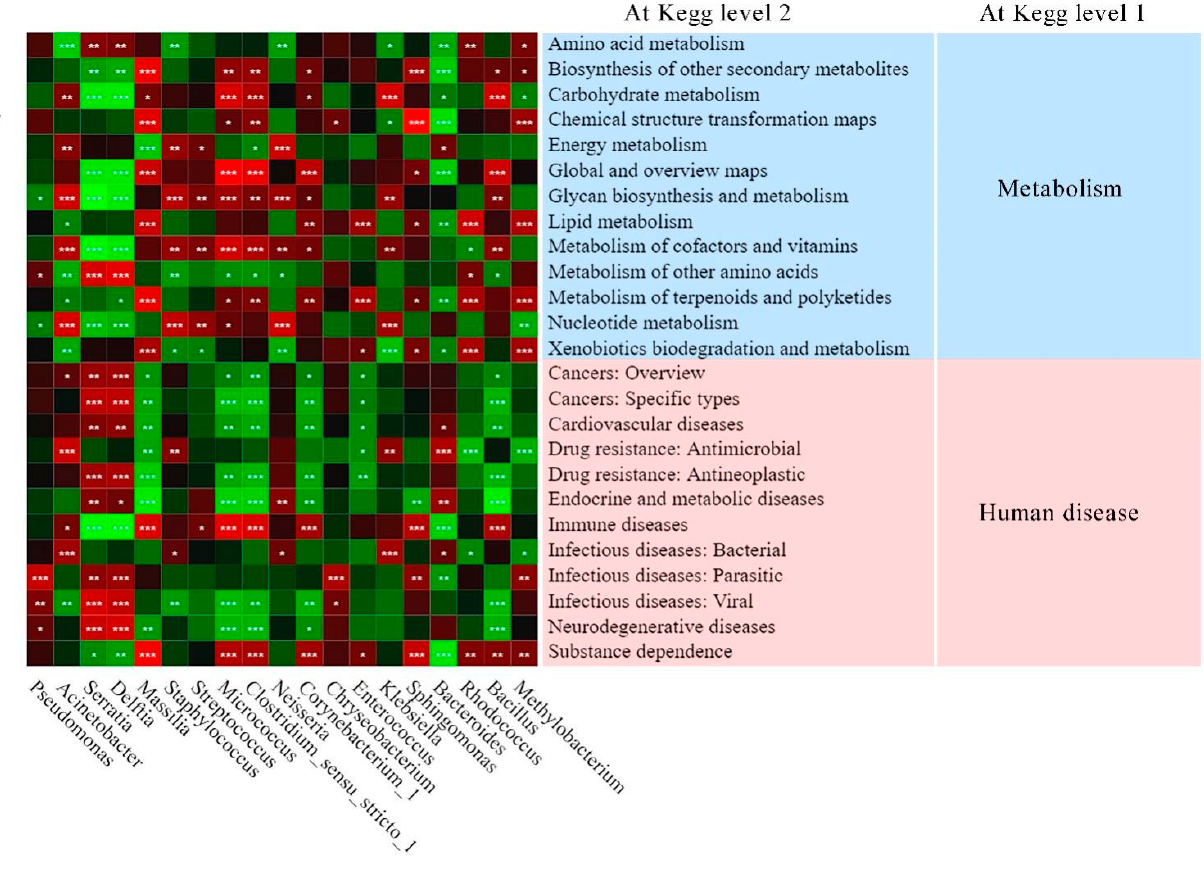
Figure 4. Spearman’s correlation coefficients were calculated for analyzing functional bacteria genus and KEGG pathways (metabolism and human disease). Red showed positive correlation and blue represented negative correlation. Significant correlation levels were indicated with * p < 0.05, ** p < 0.01, and *** p < 0.001.